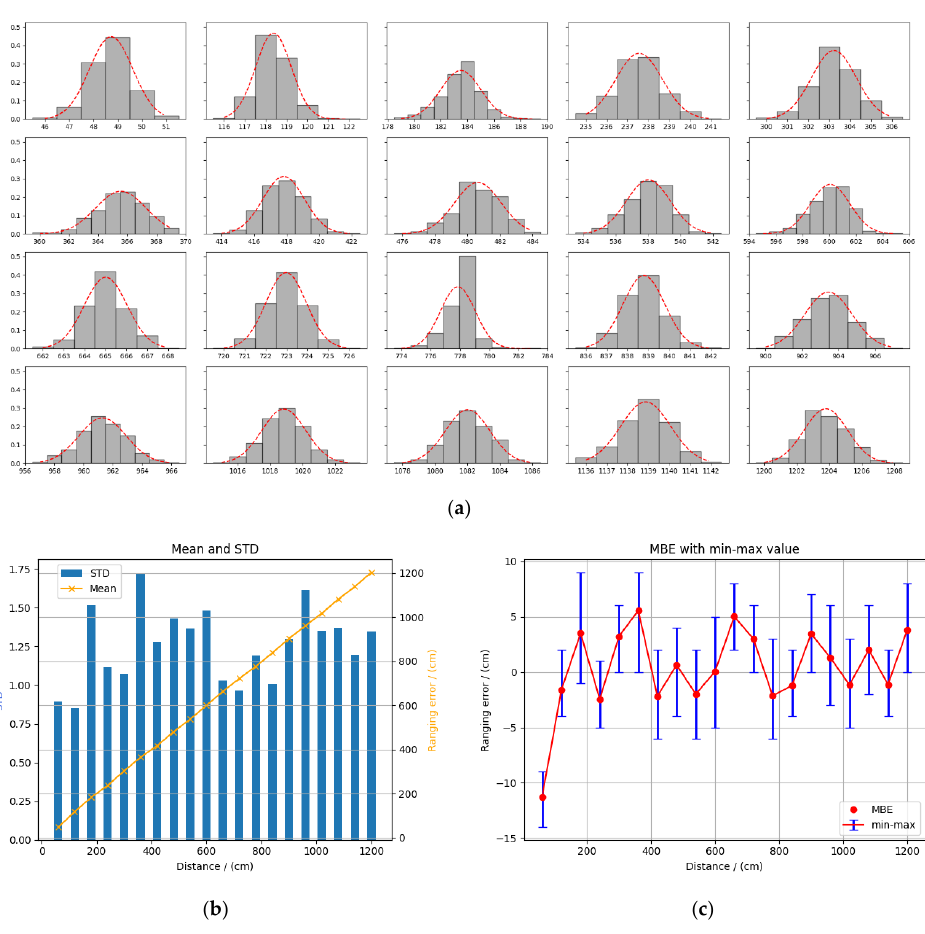
Figure A3. Ranging with an interval of 60 cm in LOS conditions. ( a ) Frequency distribution histogram of ranging data; ( b ) means and STDs of range errors; and ( c ) MBE and min–max value of ranging data.